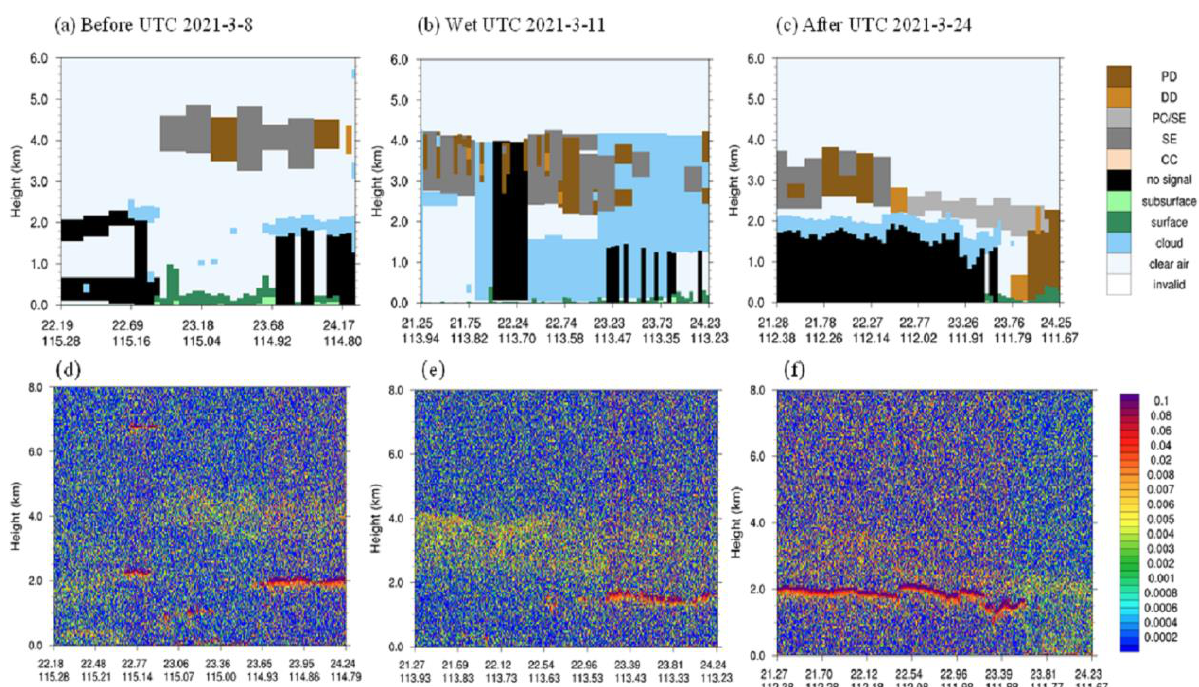
Figure 14. ( a – c ) The aerosol subtype, ( d – f ) CALIPSO 532 nm total attenuated backscatter coefficient on 8, 11, and 24 March 2021.